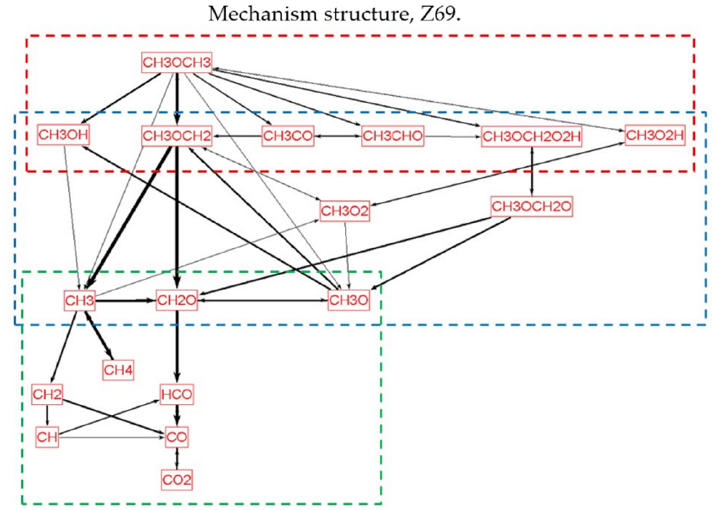
Figure 1. Mechanism structure diagram for Z69. The coloured boxes refer to the three submechanisms—base mechanism in green, intermediate hydrocarbon oxidation in blue and fuel breakdown reactions in red.